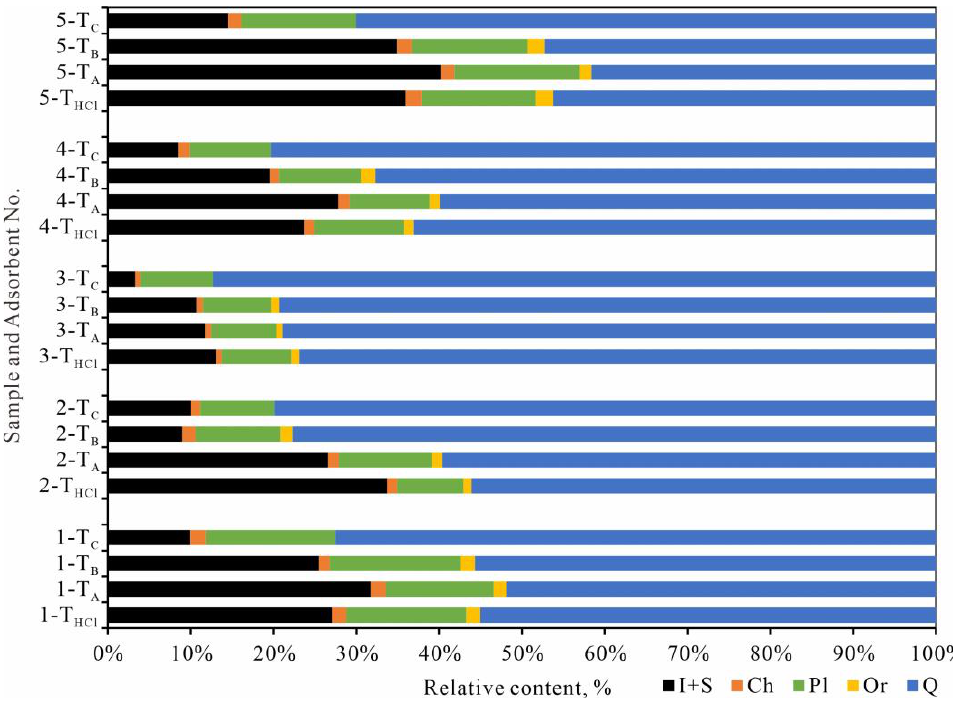
Figure 2. XRD pattern of T HCl and adsorbents. The identified minerals are Q: quartz; Or: orthoclase; Pl: plagioclase; Py: pyrite; H: hematite; I: illite; S: smectite; I/S: illite/smectite; and Ch: chlorite. * T HCl represents sample treated with hydrochloric acid.